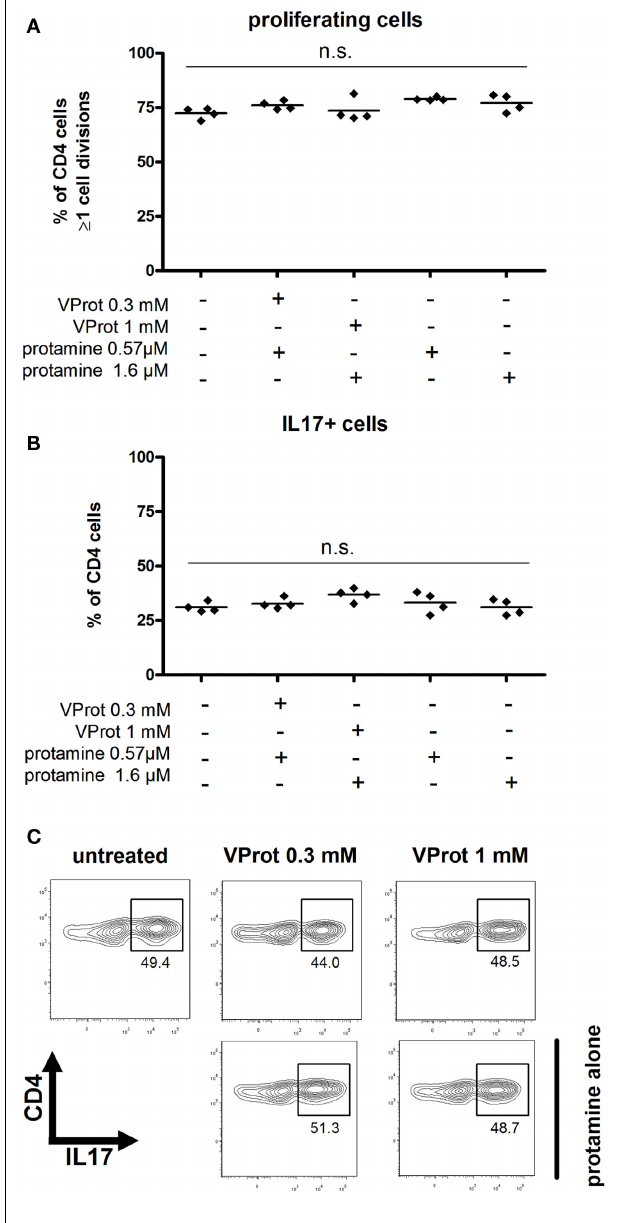
FIGURE 5 | Effects ofVProt onTh17 proliferation and cytokine production. (A) Incubation ofTh17 cells for 3 days withVProt or protamine alone had no effect onTh17 proliferation, given as the percentage of cells showing one or more cell divisions, gated on CD4-positive cells. (B) Incubation ofTh17 cells withVProt or protamine alone did not affect IL-17 production, shown as the percent of CD4-positive cells which were IL-17-positive. Percentages reflect anti-CD3/anti-CD28-stimulated cells after subtraction of baseline values from non-stimulated cells. (C) Representative flow cytometry plots showing the uncorrected percentage of IL-17-producing CD4-positive cells. n.s. not significant compared to control, by one-way ANOVA with Dunnet’s post hoc test.